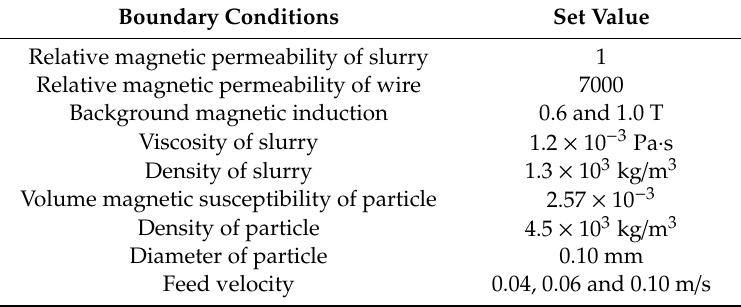
Table 1. Boundary conditions for COMSOL Multiphysics